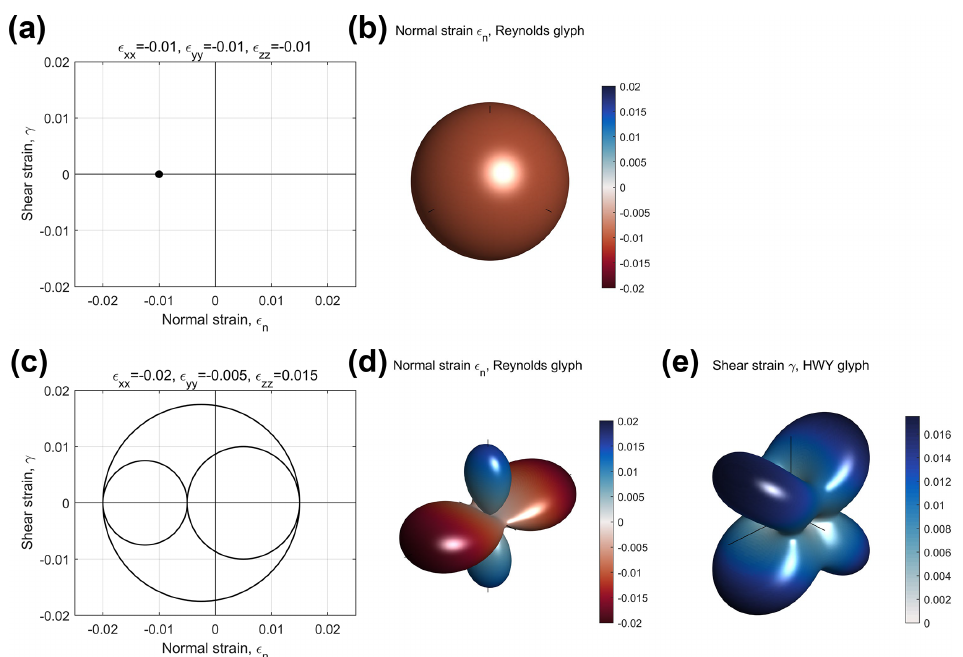
Figure 8. Examples of strain tensors depicted in Mohr space ( ε n , γ ) and as Reynolds (normal strains, ε n ) and HWY (shear strains, γ ) glyphs. (a–b) Isotropic compaction (taken as negative, red colour). (c–e) Visualisations for a general triaxial strain. Note the lobes of extensional (blue) and contractional (red) strain in the normal strain plot (d) .